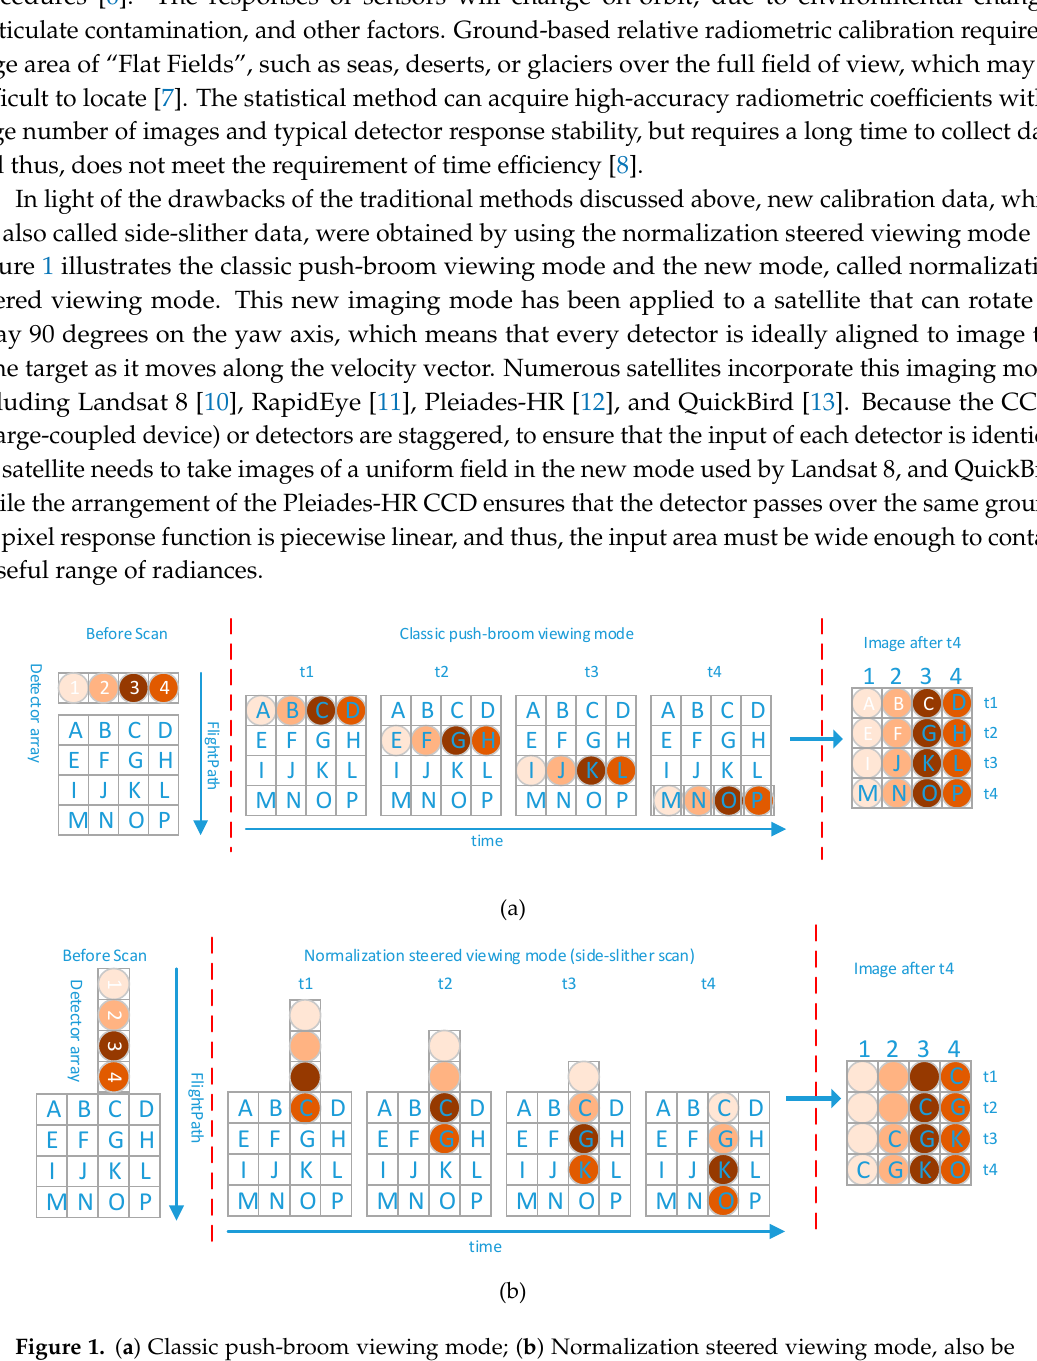
called side-slither